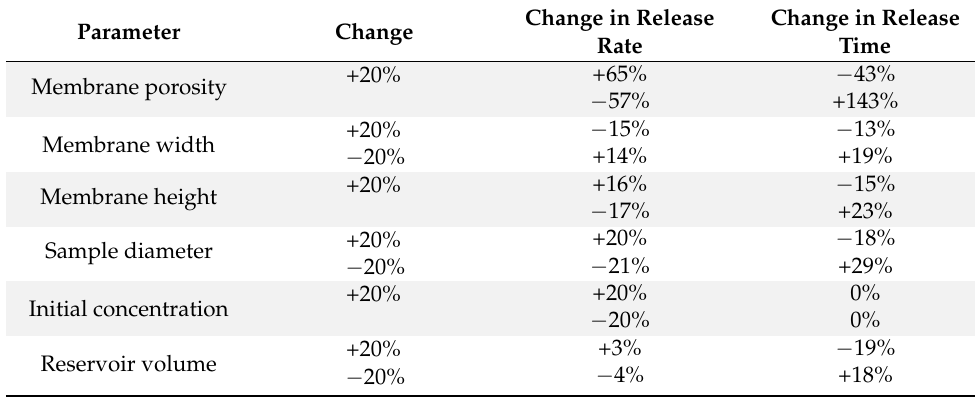
Table 2. Influence of parameter change on release rate and release time.